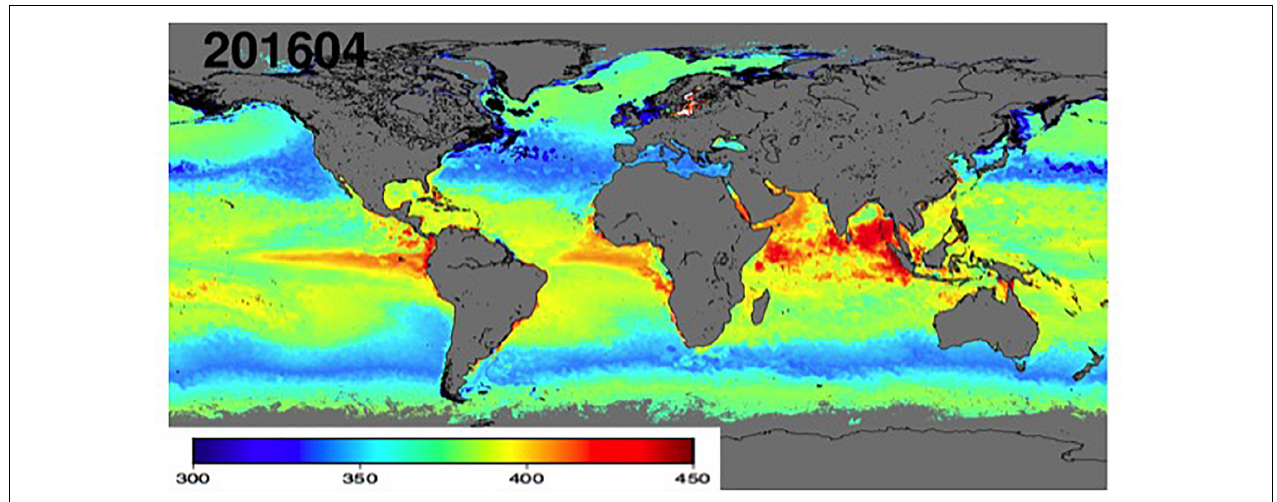
FIGURE 4 | Monthly map of pCO 2w for April 2016 created by a NN/SOM method showing the high fidelity of the output taking advantage of high-resolution remote sensing data. This example uses SOCAT data as the training set (units: µ atm) (J. Triñanes, pers.